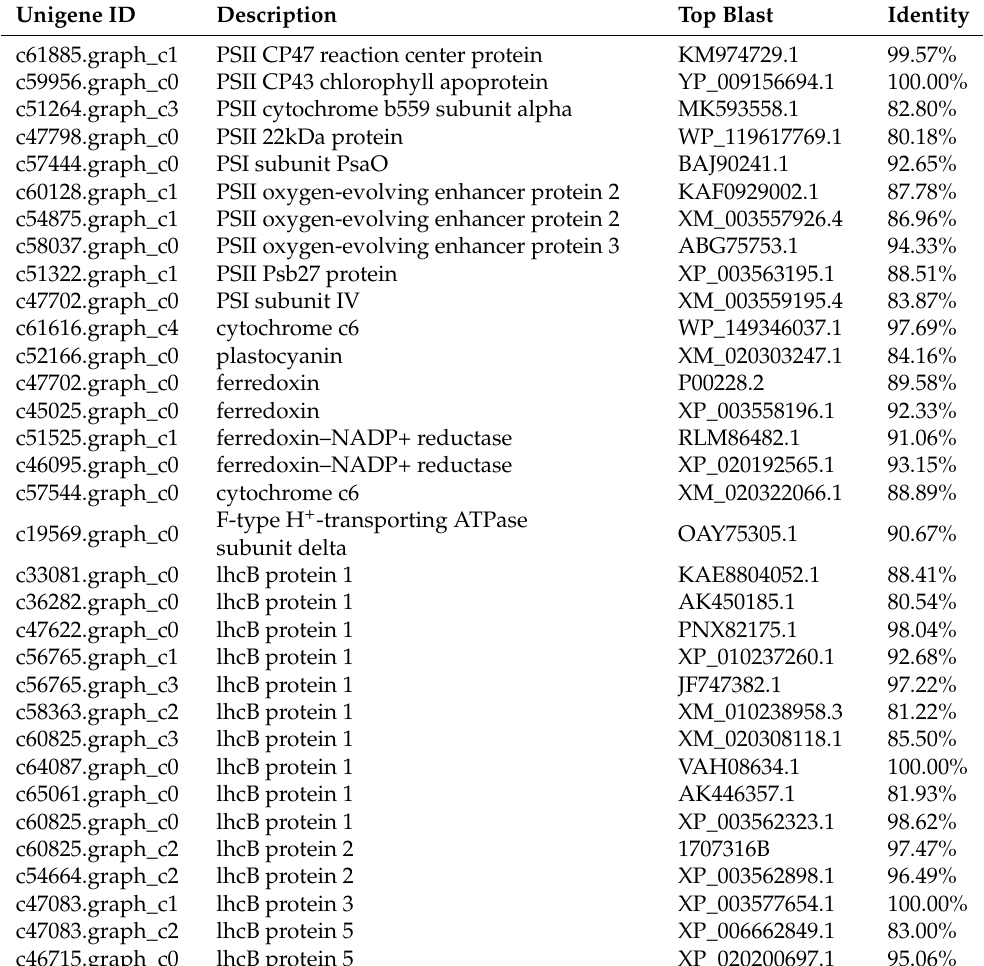
Table 1. Selected unigenes associated with the processes of photosynthesis antenna proteins and photosynthesis in Achnatherum inebrians identified in the RNA-seq analysis, including photosystem II (PSII), photosystem I (PSI), light-harvesting complex II, and chlorophyll a/b binding protein (lhcB). Unigene